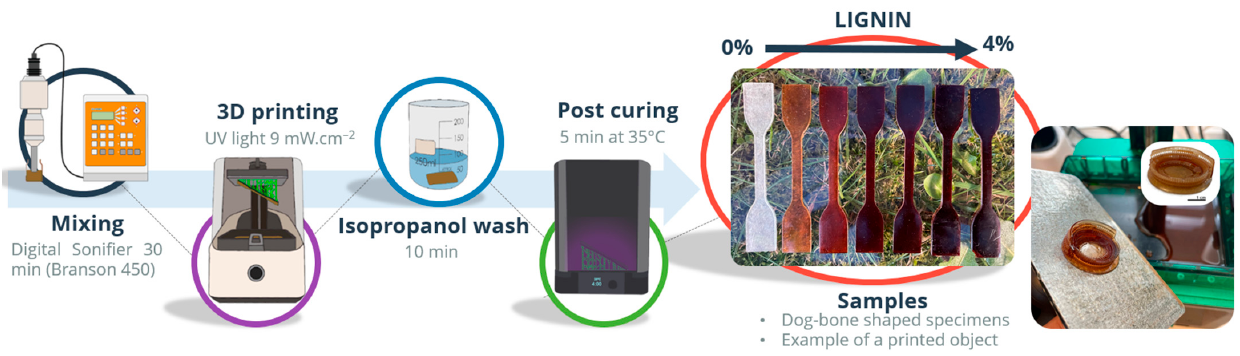
Figure 1. Diagram of sample preparation.